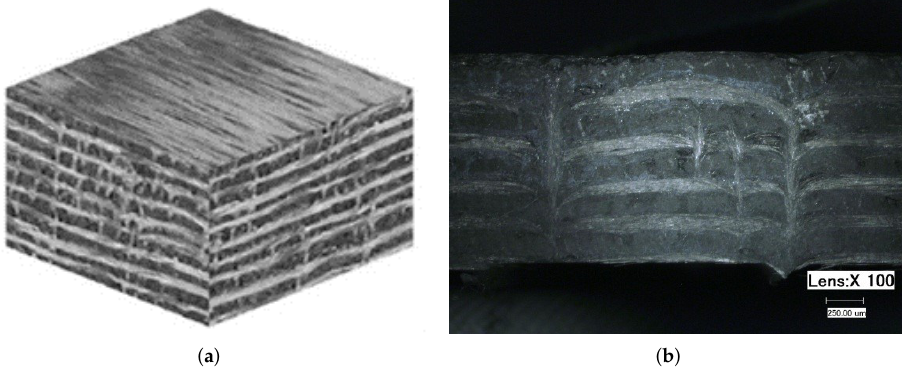
Figure 1. C/SiC composite components. ( a ) Macroscopic structure. ( b ) Microstructure.